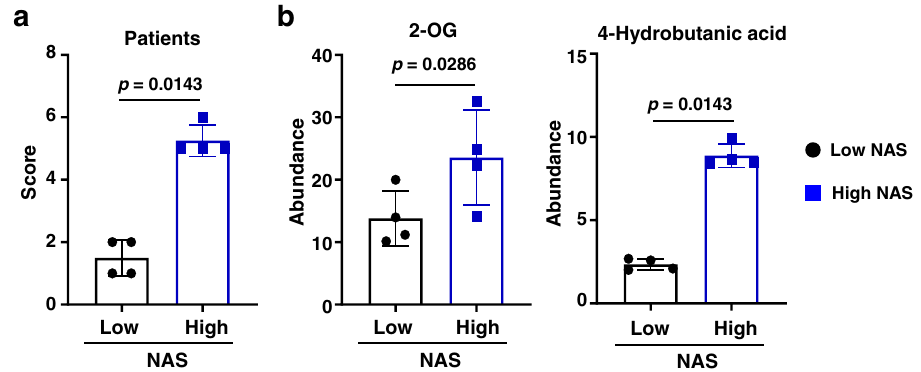
Fig. 4 | Discrepancies of liver metabolites in patients with obesity and with or without NASH. a NAS in patients with obesity and with or without NASH. According to NAS, eight patients with obesity were divided into two groups: patients with obesity and NAS>4 (high) and individuals with obesity and NAS < 4 (low). b Signi fi cantlyincreasedproductionofhepatic2-OGand4-Hydroxybutanoic